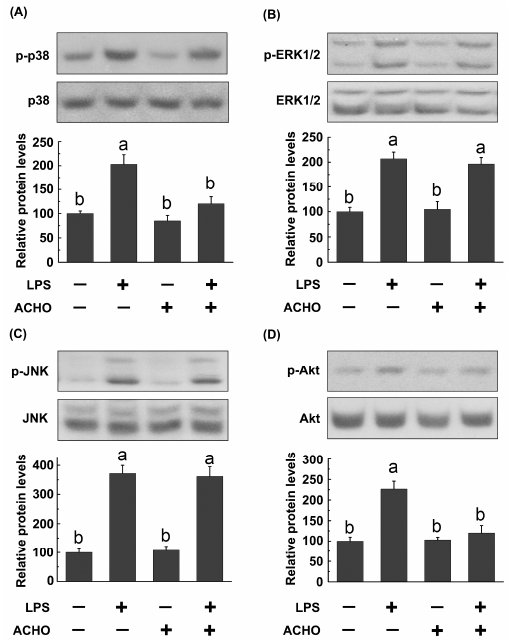
Figure 3. Inhibitory effect of ACHO on activation of MAPK and Akt signaling pathways in LPS-induced macrophage cells. RAW264.7 cells were pretreated with ACHO (100 μ g/mL) in FBS-free medium for 12 h and then exposed to LPS (200 ng/mL) for 30 min. After that, cells were collected and the phosphorylated levels of p38 ( A ); ERK1/2 ( B ); JNK ( C ) and Akt ( D ) were determined by western blot. Data represent the mean ± SD ( n = 3). Data with different superscript letters are significantly different ( p < 0.05).